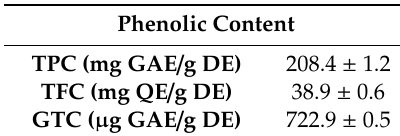
Table 1. The total phenolic (TPC), flavonoid (TFC) and gallotannin (GTC) content in the leaves